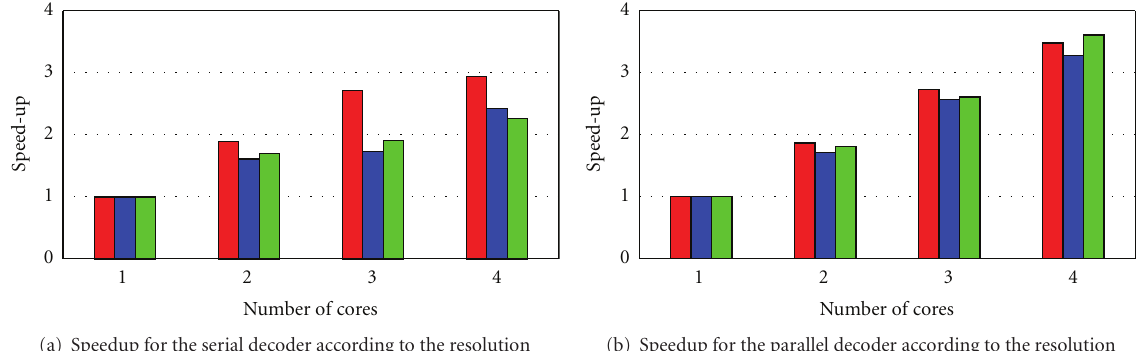
Figure 11: Speedup of the MPEG-4 SP decoder on an Intel i7-870 processor at QCIF (red), SD (blue) and HD (green) resolutions.